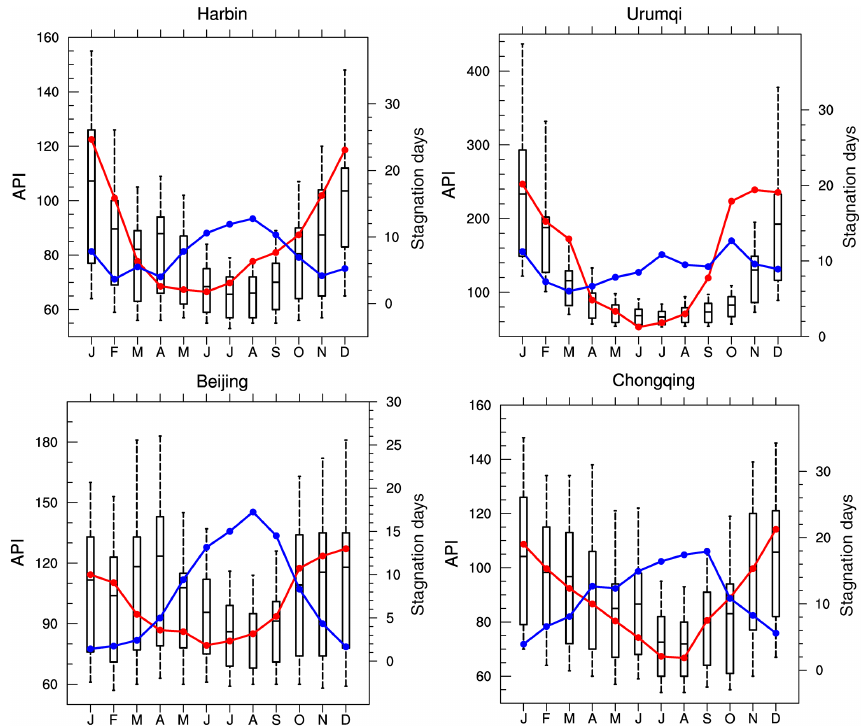
Figure 11. Monthly variations of the API averaged over 13 years (2000–2012), as well as the corresponding air stagnation days under the ASI and BSI criteria. Blue line: ASI; red line: BSI. Monthly mean values of the API are given as horizontal bars in the middle, 25 and 75% percentiles are shown as boxes’ lower and upper boundaries, and 10 and 90% percentiles as lower and upper whiskers.